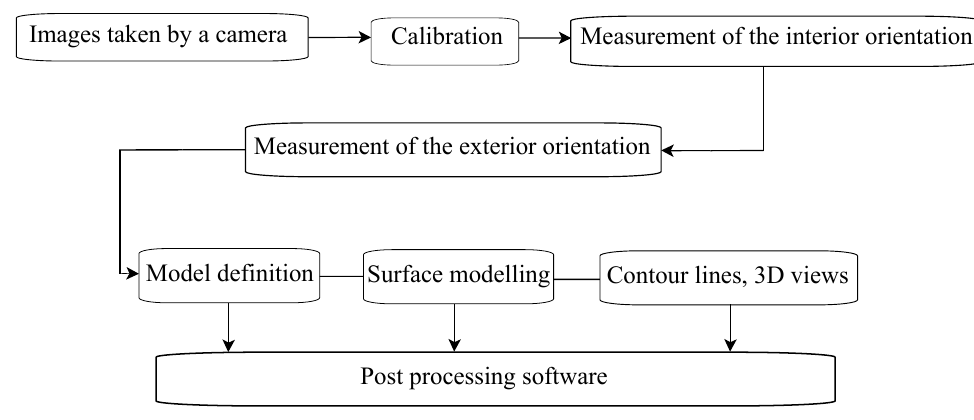
Figure 2. Overview of the photogrammetry